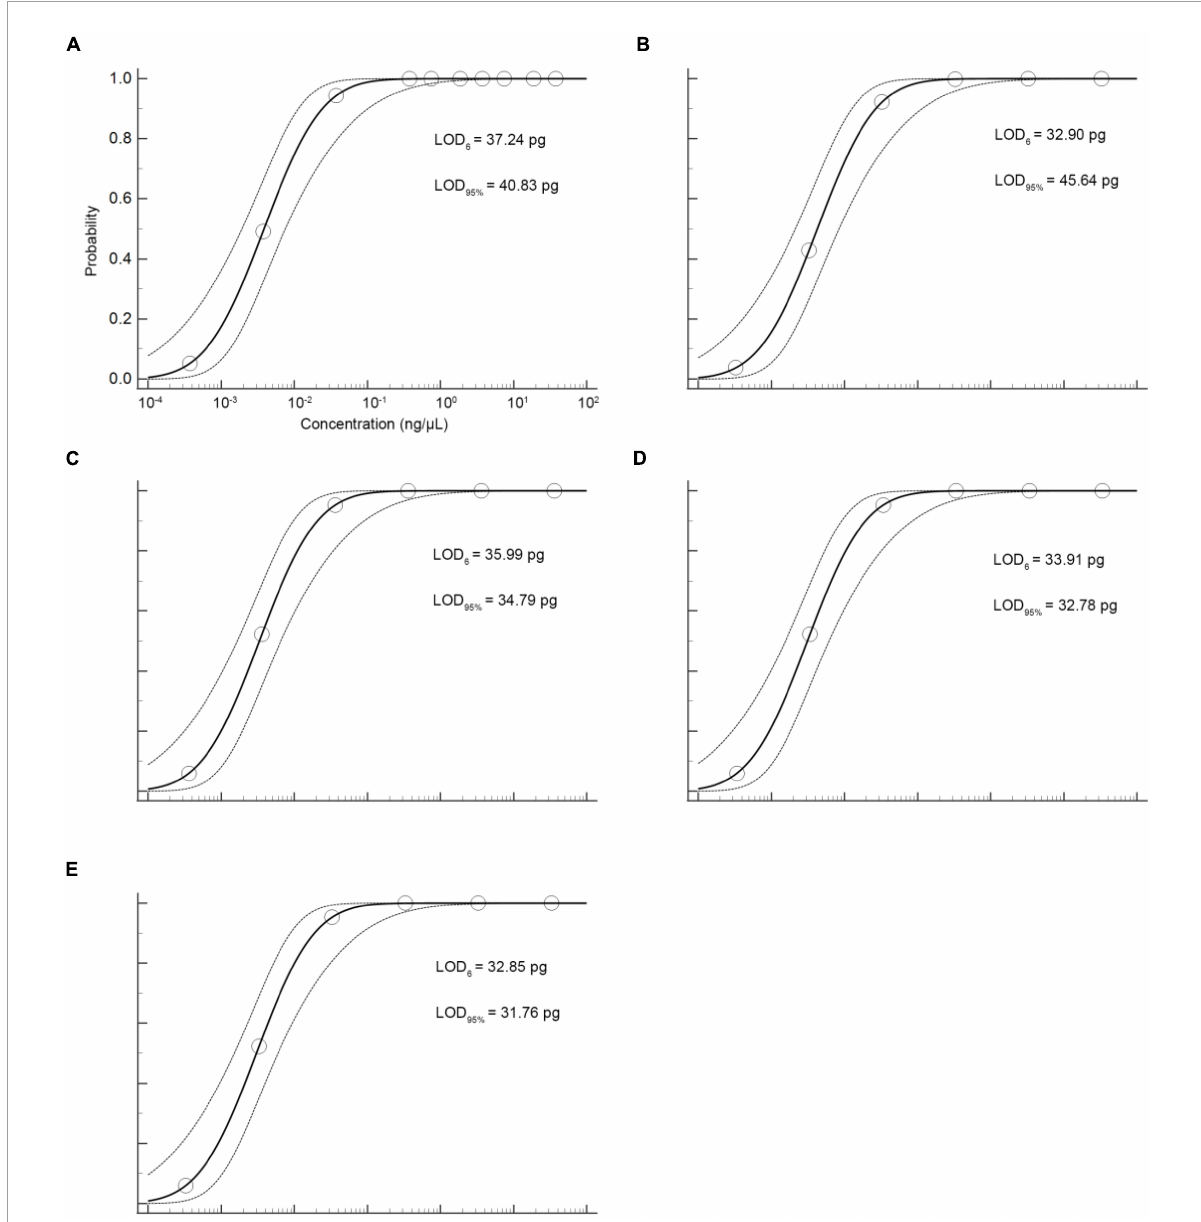
FIGURE4 Probit regression analysis using MedCalc Software was performed on data of 6 replicates ( m = 6, n = 3) from serial dilutions by the specific qPCR methods. (A) L. inermis , (B) L. lagocephalus , (C) L. gloveri , (D) L. lunaris , (E) L. spadiceus